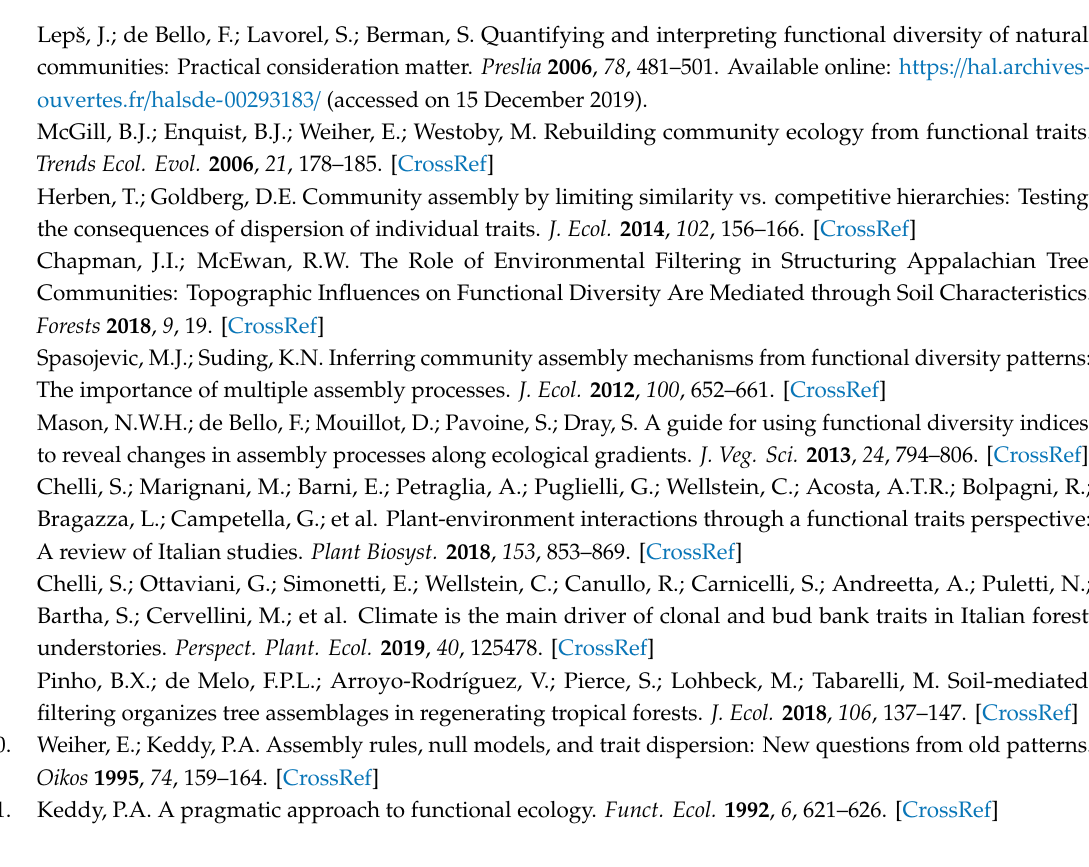
Figure S1: Principal component analysis for the small vegetation plots (2 × 2 m, 100 plots in total) across 10 IM sites in Slovenia, Figure S2: Linear regressions between the SES FDis of four functional traits (plant height, seed mass, specific leaf area, leaf dry matter content) and species